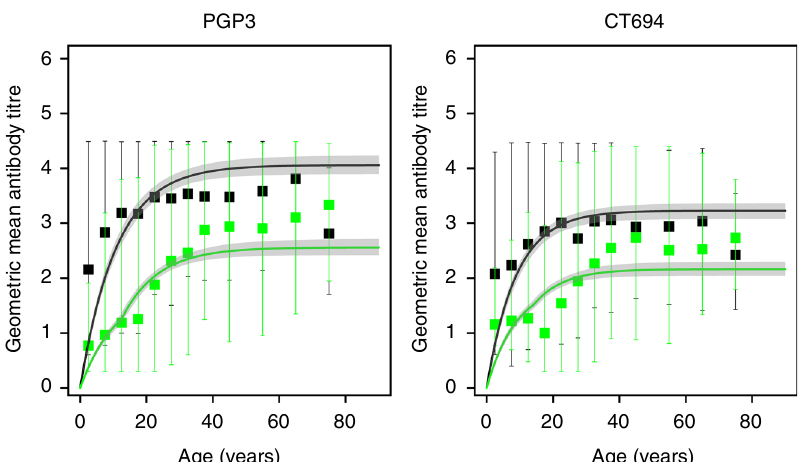
Fig. 2 Fits of the best-performing antibody acquisition model for data from Nepal. Black points indicate the pre-MDA data and green indicate the post- MDA data. Error bars on the squares and triangles indicate the 95% binomial con fi dence intervals. Solid black lines running through the sero-prevalence data were generated with the median parameter estimates from each model fi t. The shaded grey region represents 95% credible intervals of the model predictions. Uncertainty was generated by drawing 500 independent samples from the posterior distribution